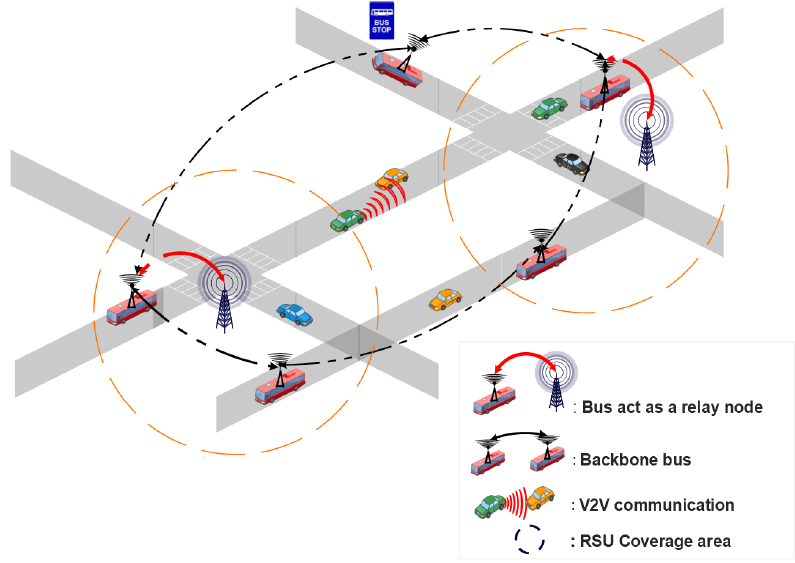
Figure 7. Mobile infrastructure based on VANET